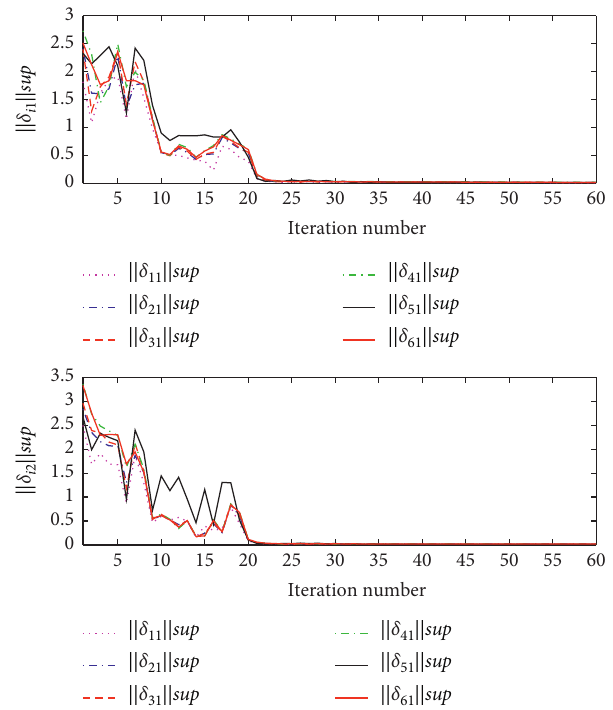
Figure 9: Consensus errors of six follower